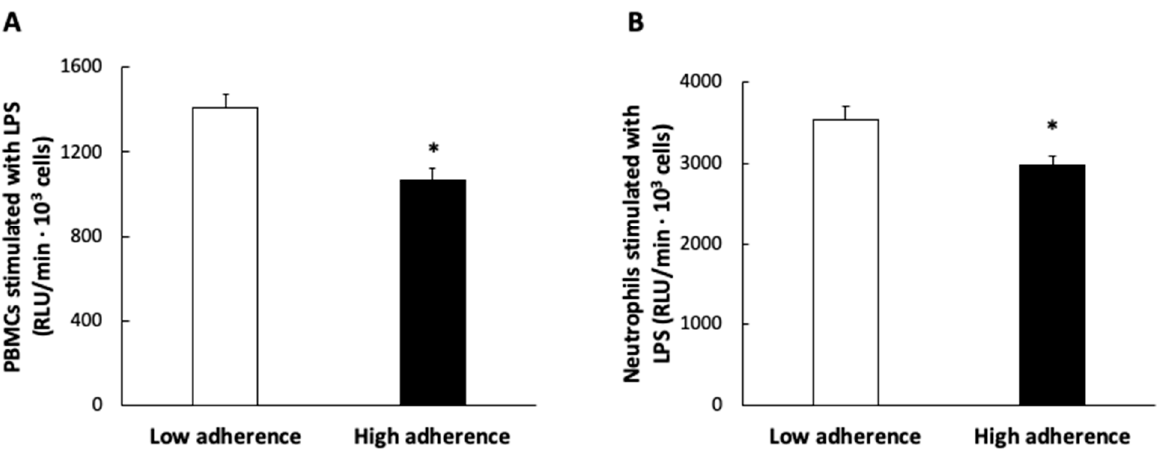
Figure 4. Peripheral blood mononuclear cells (PBMCs) ( A ) and neutrophils ( B ) stimulated with lipopolysaccharide (LPS) according to the Mediterranean Dietary Pattern score. Results are presented as mean ± SEM. Data points in bold (*) are significant ( p < 0.05) by Student t -test. Table 5 shows the correlations between the different parameters analyzed and the MDP adherence score. Weight, abdominal obesity, triglycerides, and plasma ghrelin were inversely correlated with greater adherence to MDP with p < 0.01 and height, HbA1c, plasma IL-1 β , and XOD levels, ROS production in PBMCs by LPS, and urine MDA with p < Table 5. Correlation between adherence to the Mediterranean Diet Pattern and parameters ana- lyzed. Correlation Weight